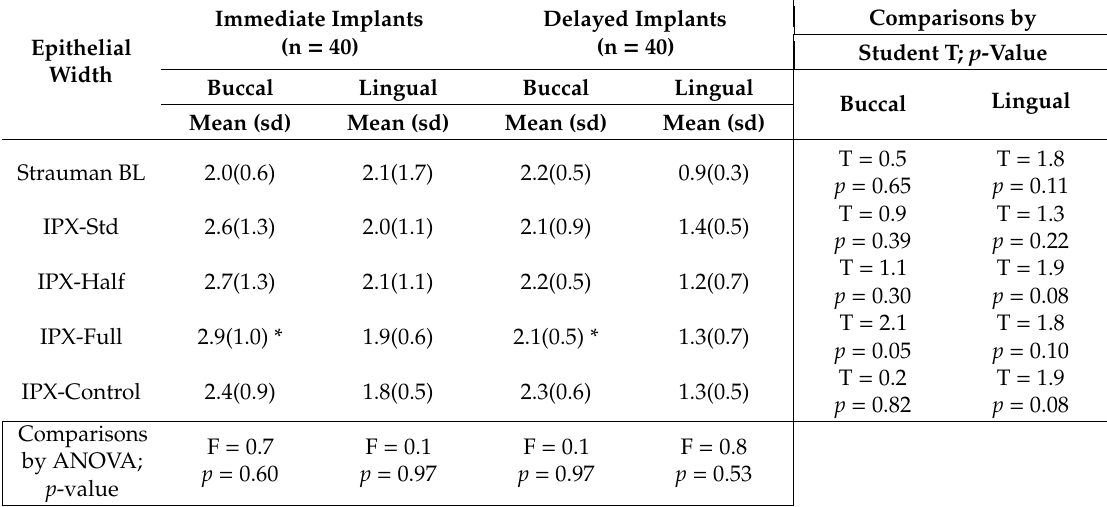
Table 3. Comparison of the epithelial width (the distance between PM and aJE) between deferred and immediate implants in both the buccal and lingual sides (mm) among the implant subgroups. * Statistically significant inter-group comparisons according to ANOVA test ( p <